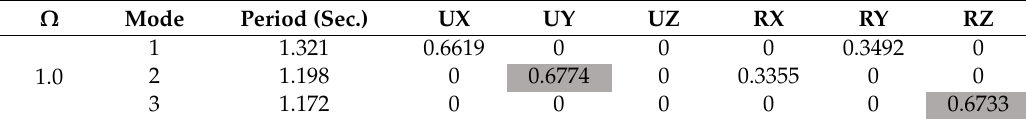
Table 6. Modal Participating Mass Ratio Buildings (with b / r = 3.16, 1 < Ty < 2 s, Ω = 1.0).